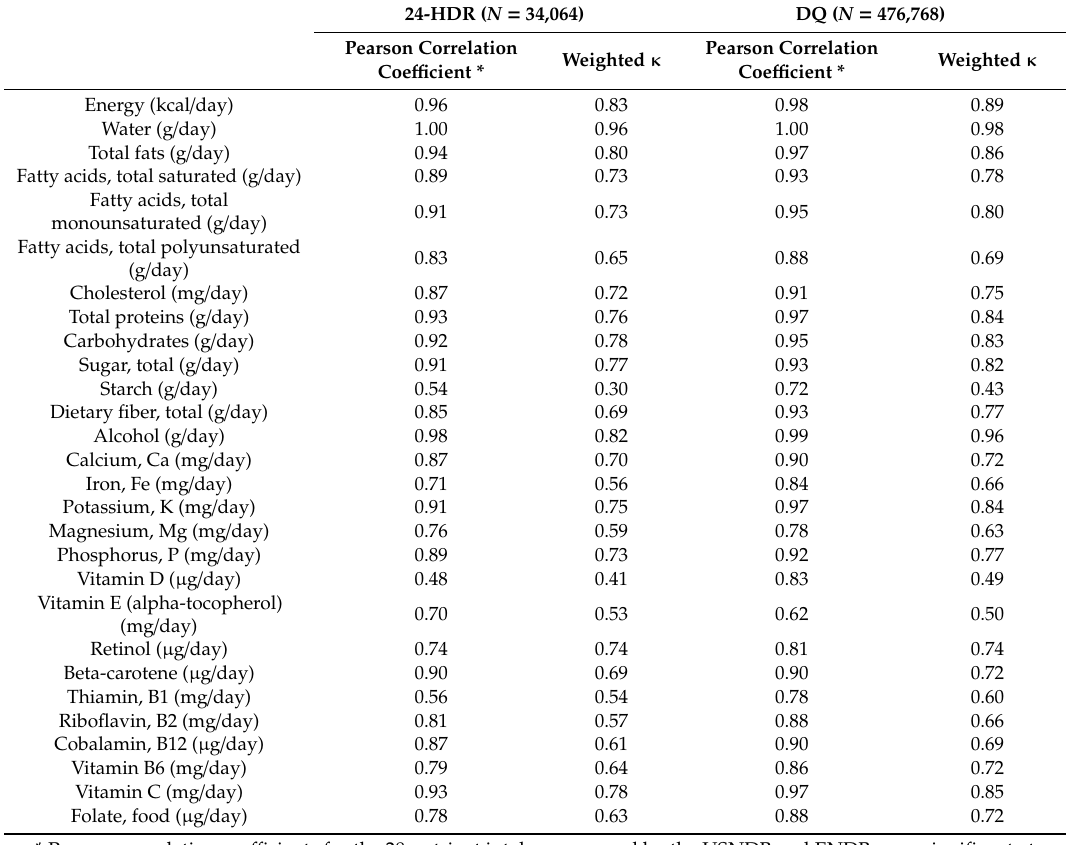
Table 3. Pearson correlation coe ffi cients and weighted kappas ( κ ) for dietary intakes of 28 nutrients estimated by the U.S. nutrient database (USNDB) and the EPIC nutrient database (ENDB), reported for the 24-h dietary recall data (24-HDR) and the dietary questionnaire data